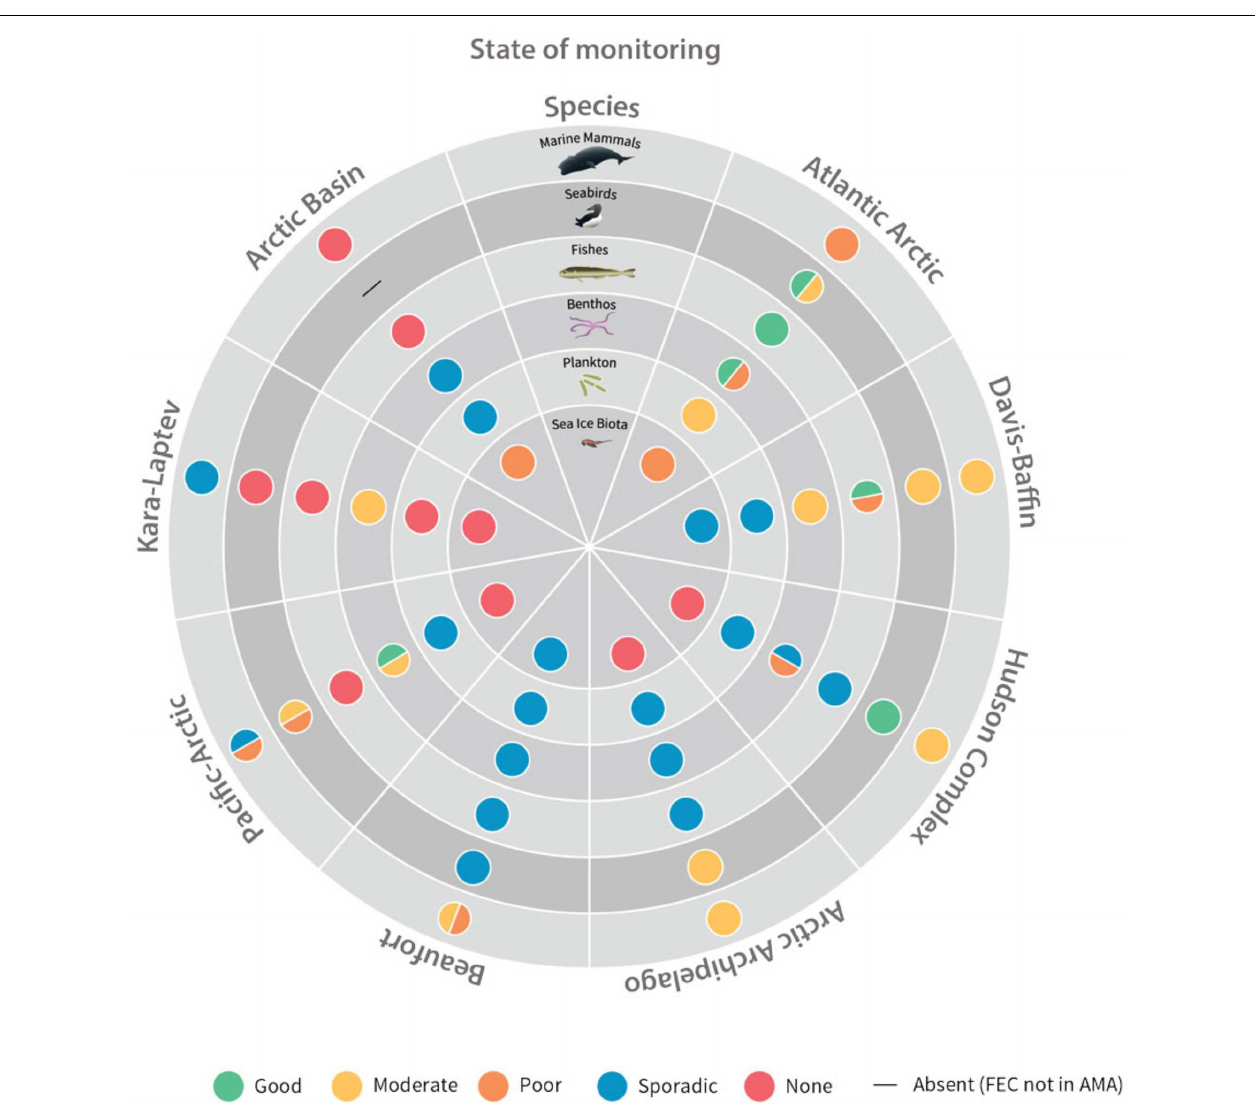
FIGURE 3 | Current status of monitoring across Arctic Marine Areas. Each concentric ring represents a group of focal ecosystem components and each segment represents a specific Arctic Marine